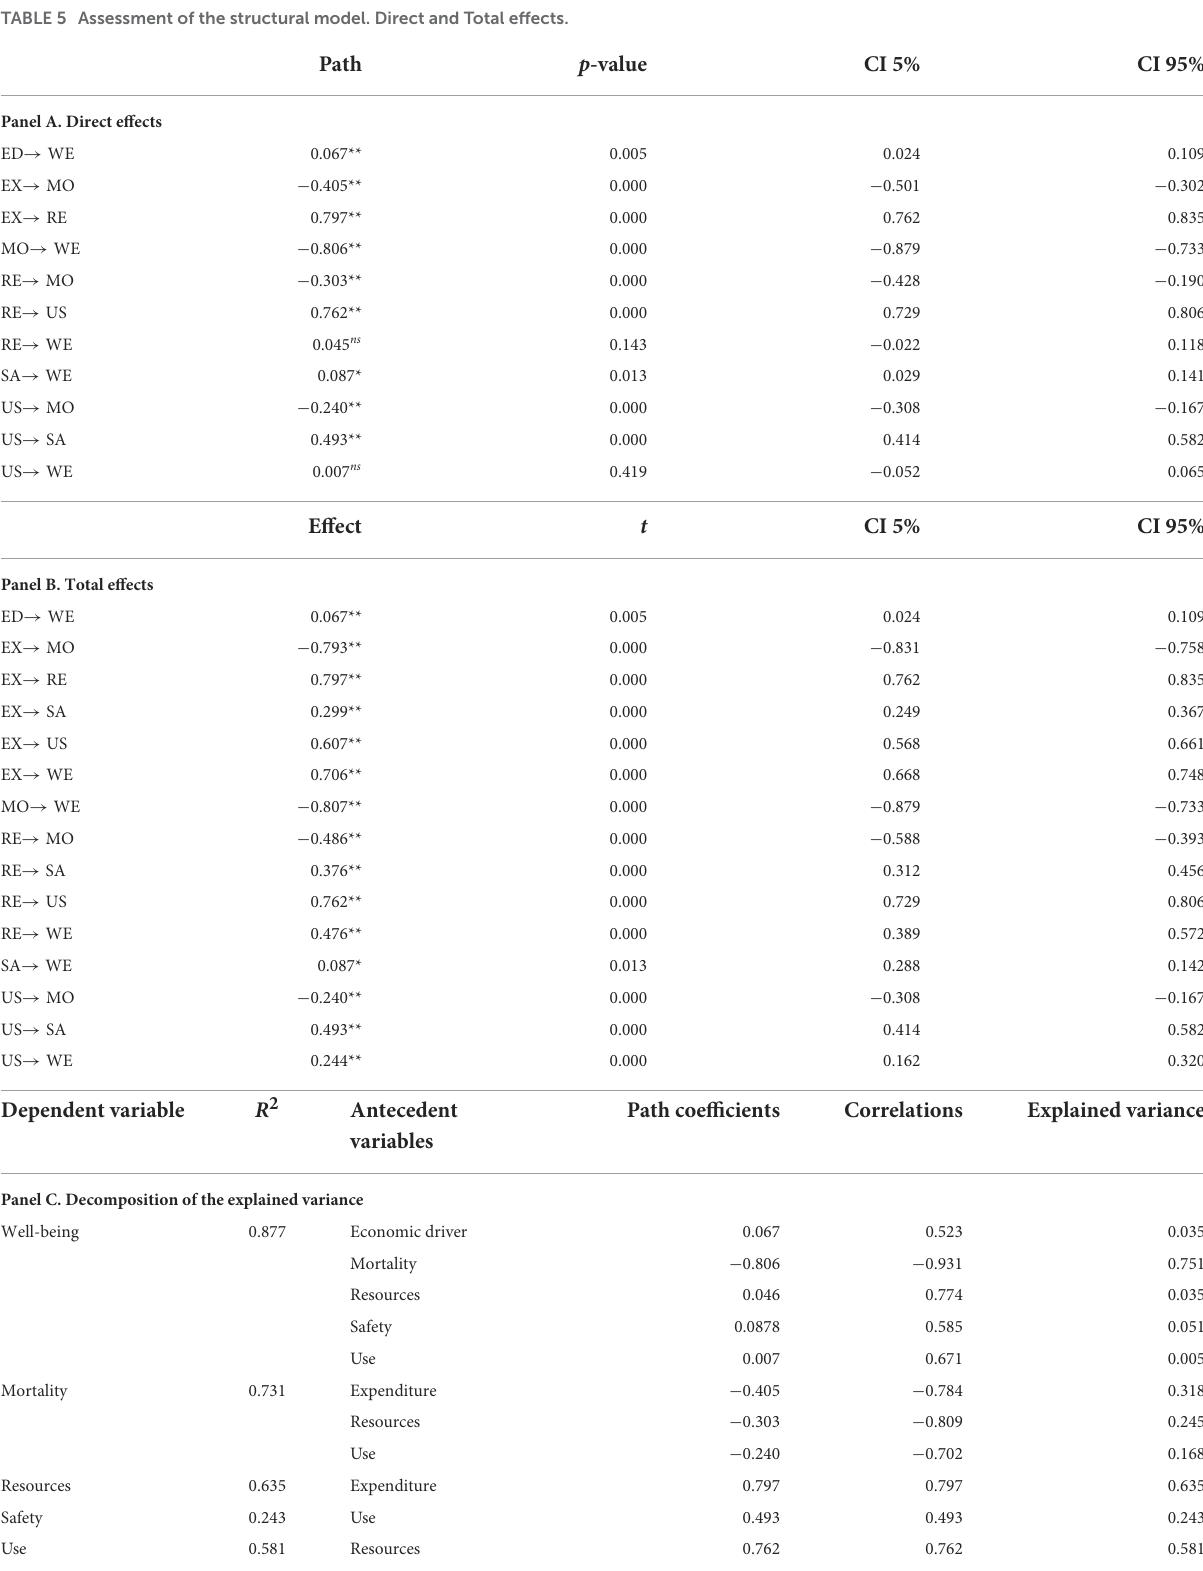
TABLE 5 Assessment of the structural model. Direct and Total